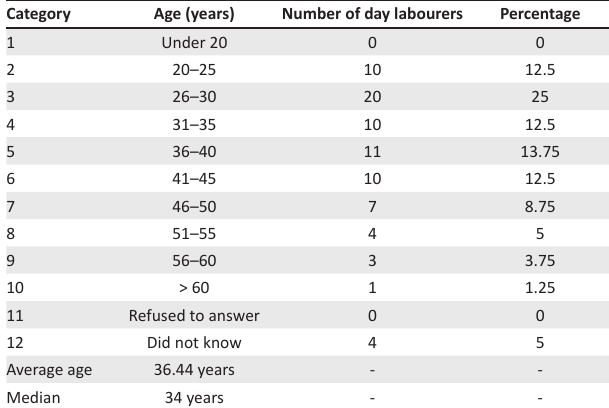
TABLE 2: Age distribution of the day labourers in Windhoek, 2017.